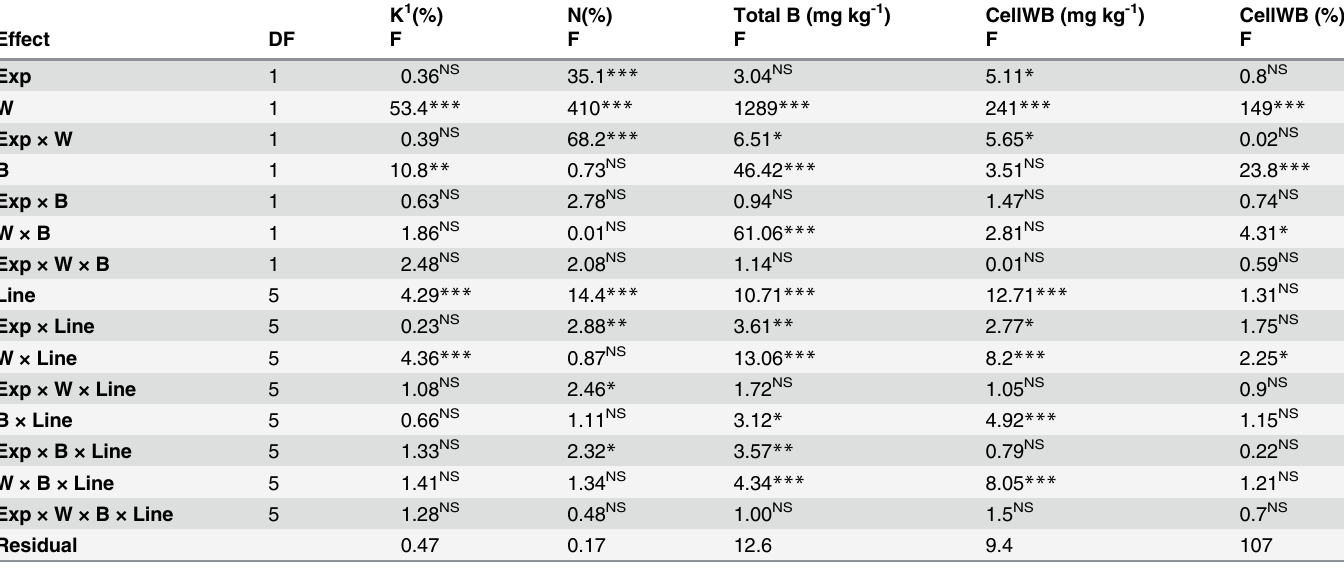
Table 2. Effect of source of variance (F value and P significant level) on cotton leaves K, N, and total B, cell wall B (CellWB), and cell wall B contri- bution to the total B (CellWB %) in near-isogenic lines (Line) expressing fuzzy and fuzzless seed phenotypes under water stress (well-watered and water stressed plants; W) with and without foliar B application (B) in a repeated (Experiment 1 and Experiment 2; Exp) greenhouse